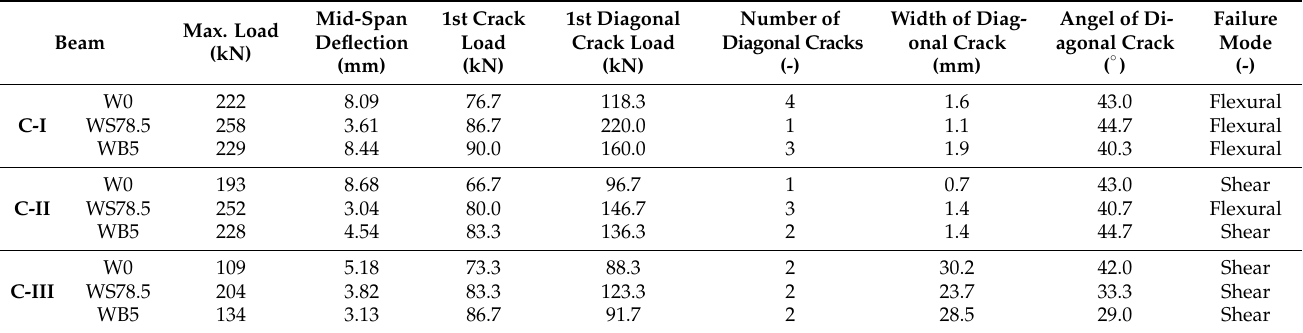
Table 2. Summary of Test Results for all